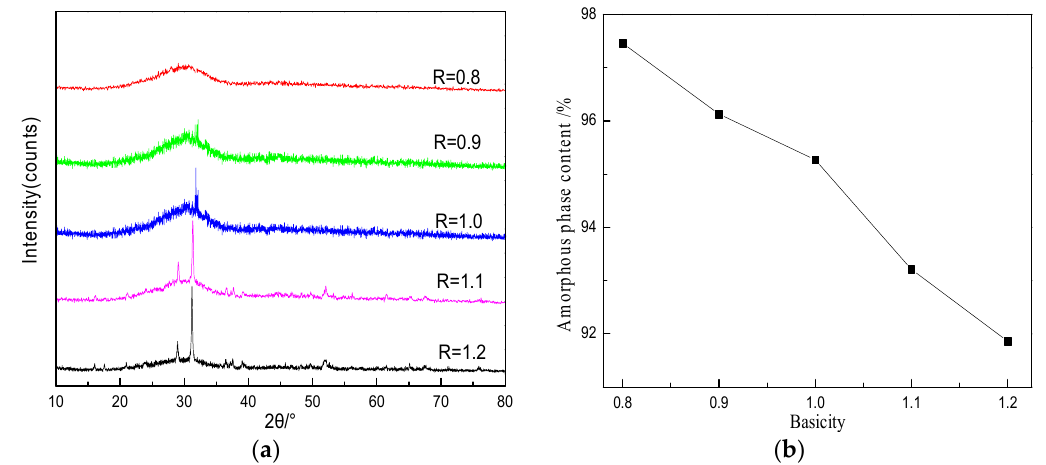
Figure 6. Analysis of X-ray diffraction patterns and amorphous content of slag beads with different basicities. ( a ) XRD analysis of slag beads; ( b ) Amorphous content of slag beads.